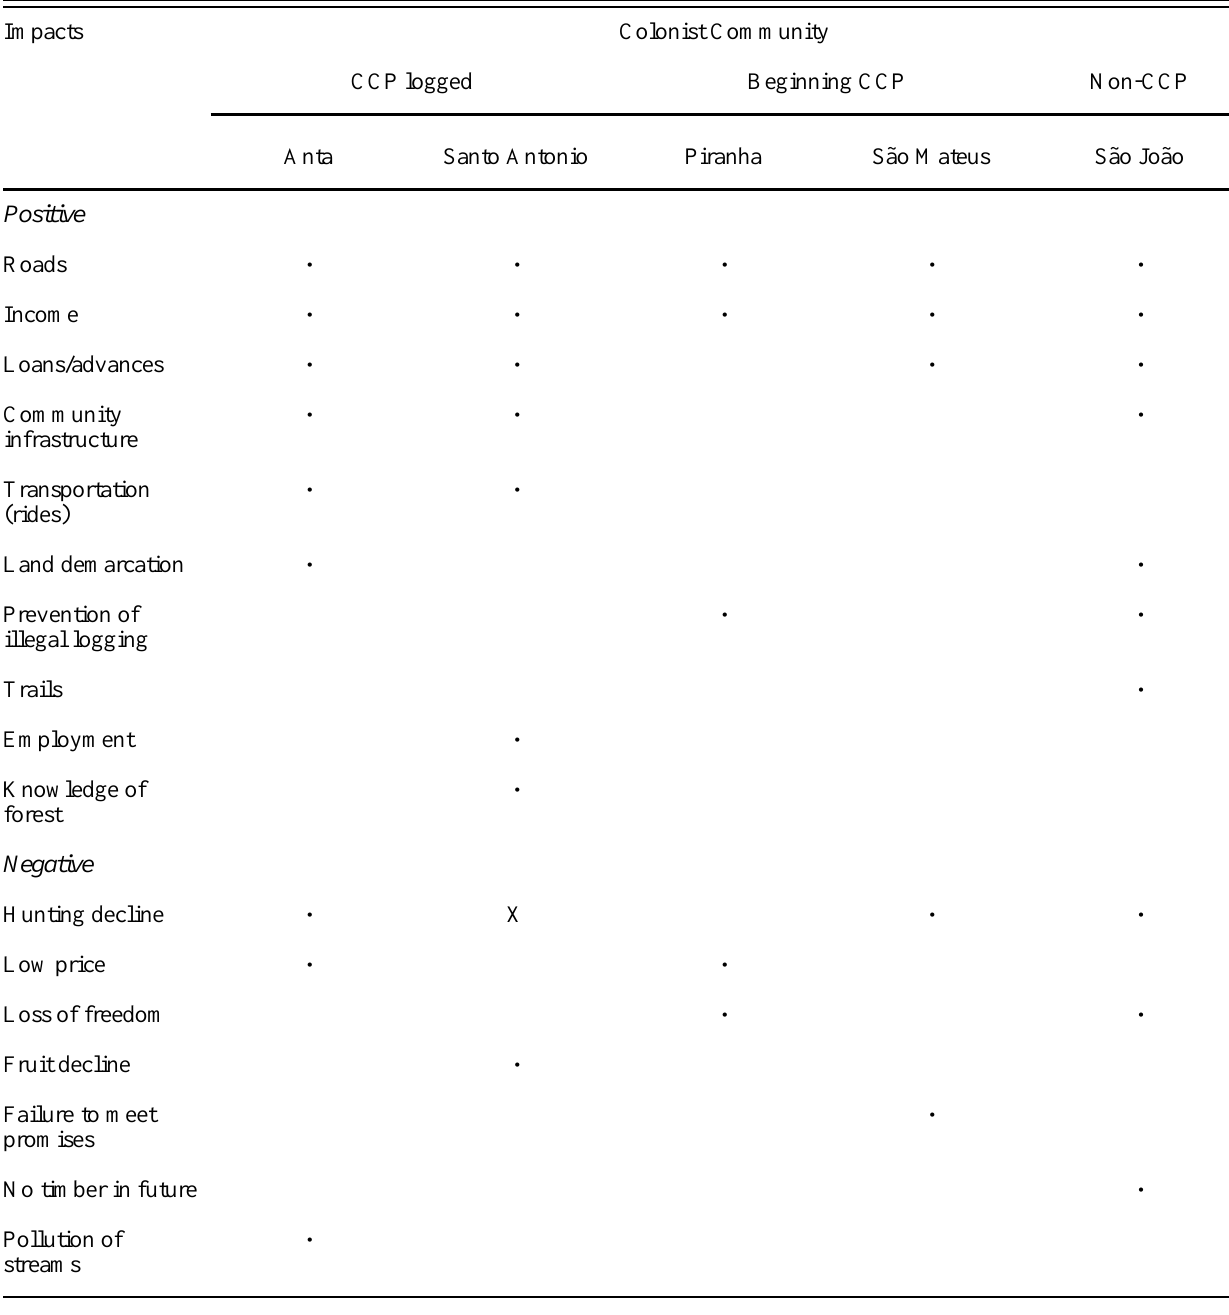
Table 3. Community perceptions of logging impacts expressed at PRA workshops. (CCP logged = already participating in full-scale logging; Beginning CCP logging = some sales from agricultural clearings, signed contracts; non-CCP = have yet to sign contracts; X - Community members disagreed as to whether or not there had been hunting